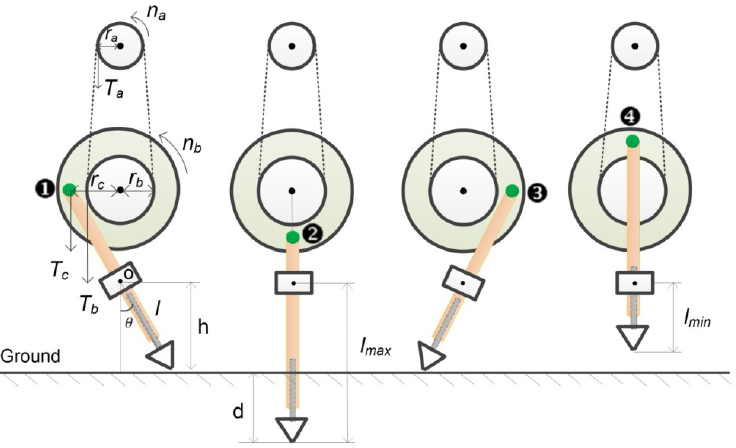
Figure 3. Transmission of the weeding mechanism.